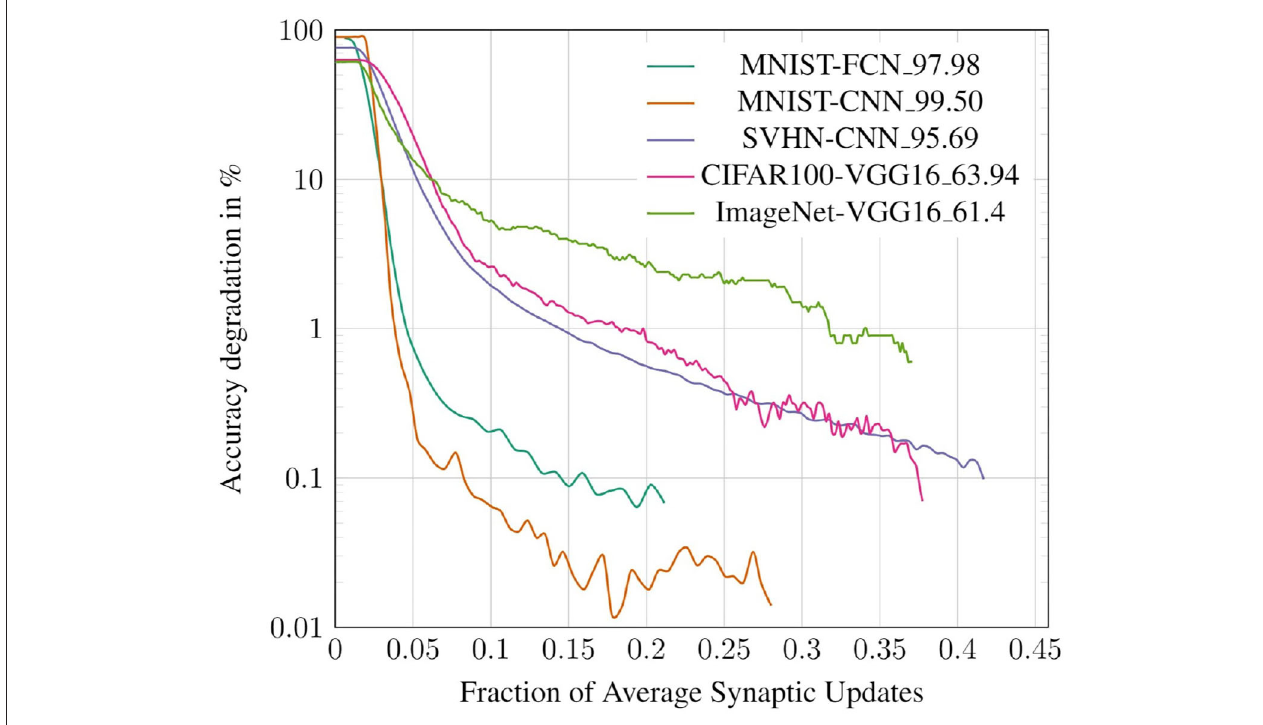
FIGURE 11 | Accuracy degradation vs. synaptic updates for various benchmarks.